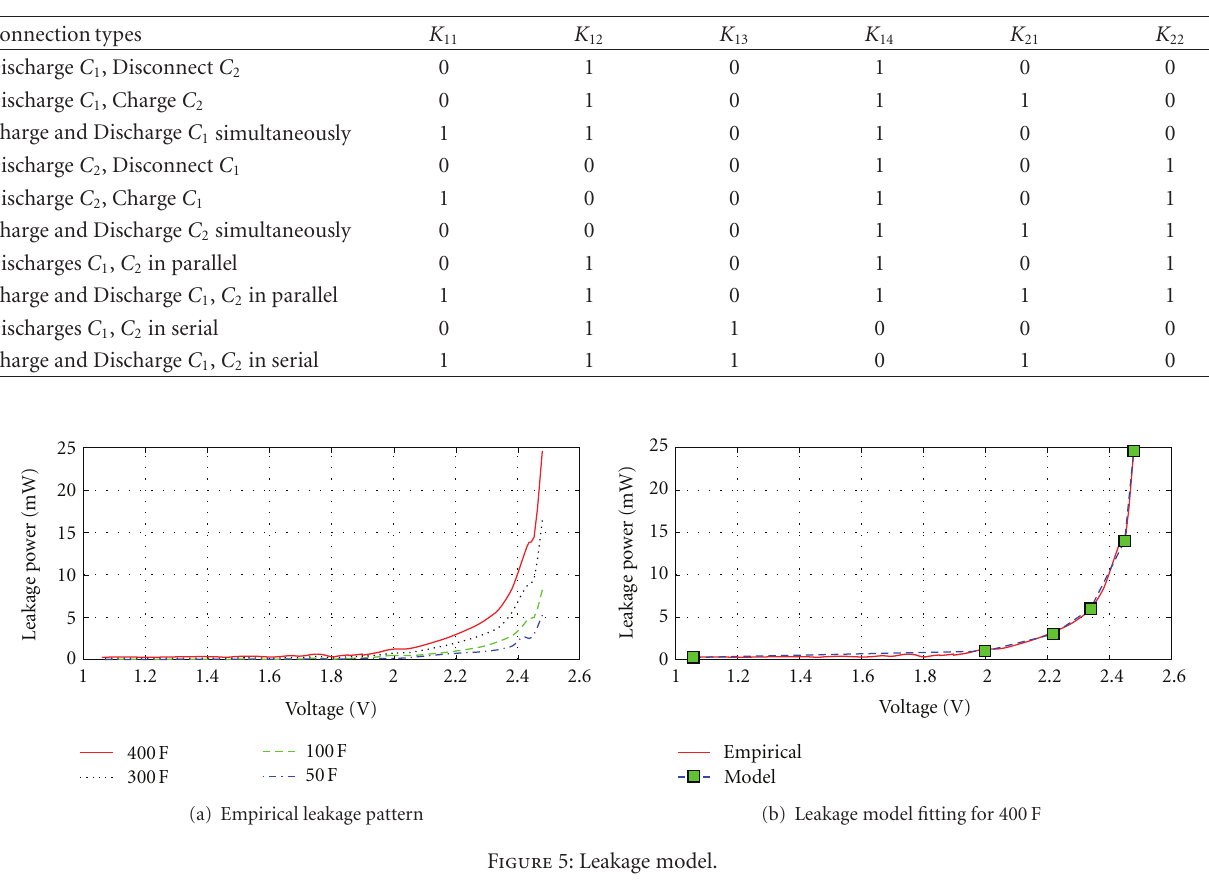
Table 1: Di ff erent types of connections.